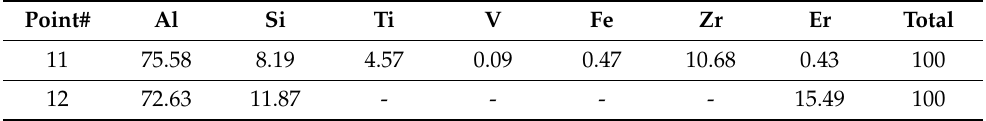
Table 2. Chemical composition (at%) in points identified as 11 and 12 in maps of Figure 9.